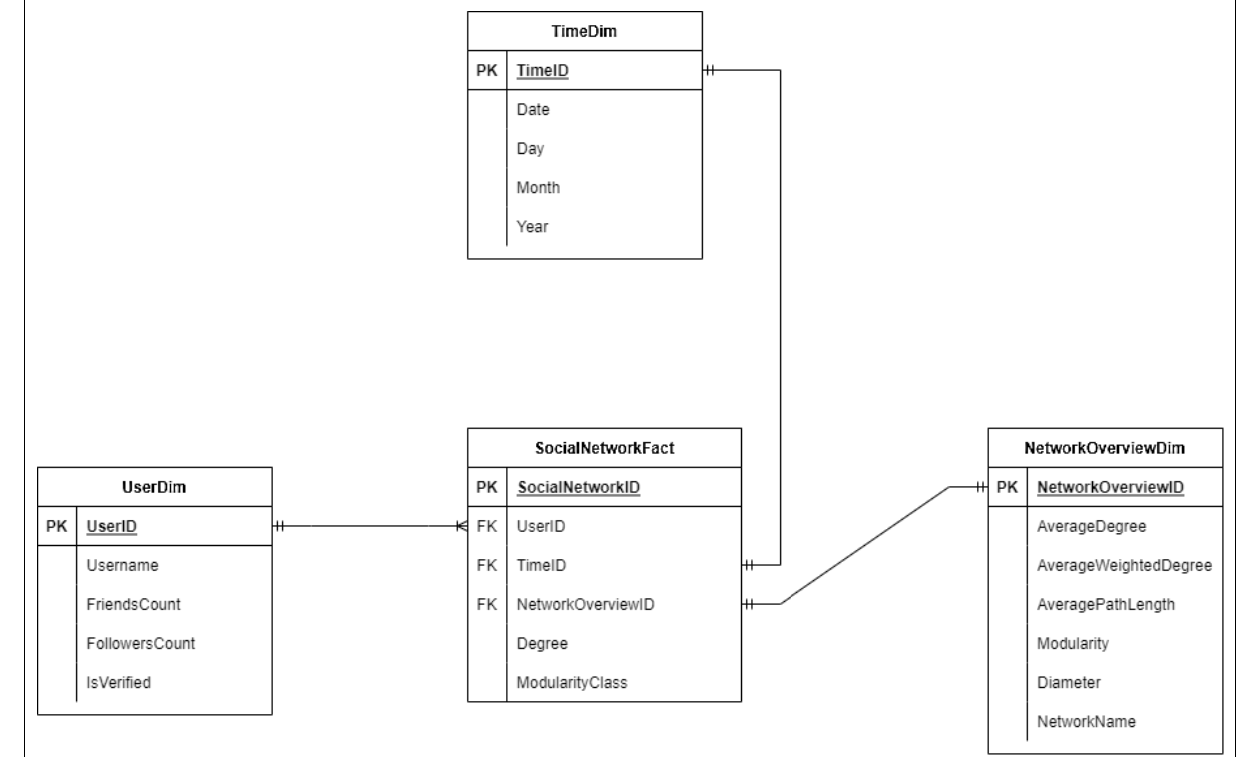
Figure 3. Database design for Data Warehouse using Star Schema